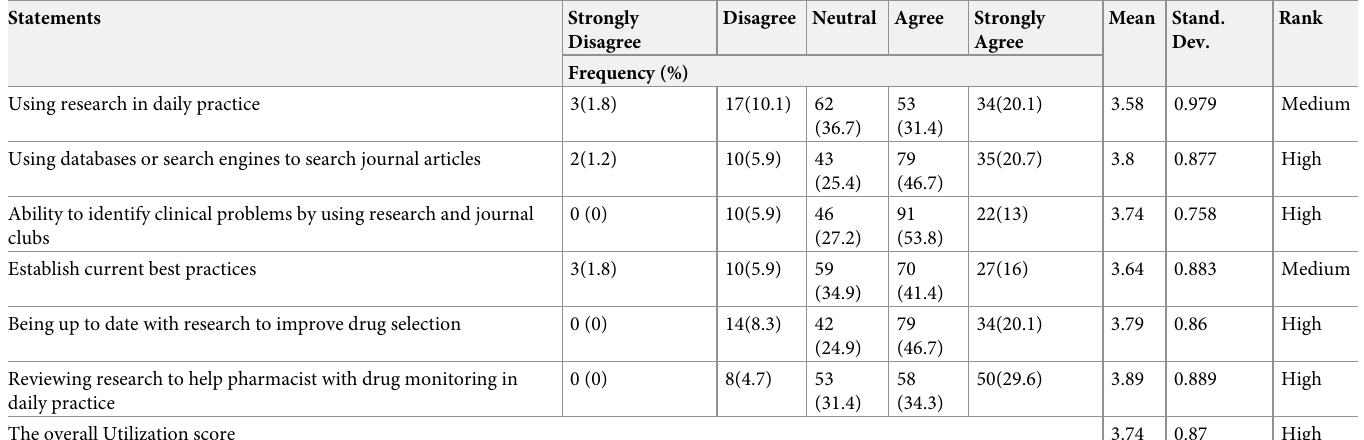
Table 3. Descriptive statistics of pharmacists responses pertaining to research utilization in pharmacy practice (n = 169).